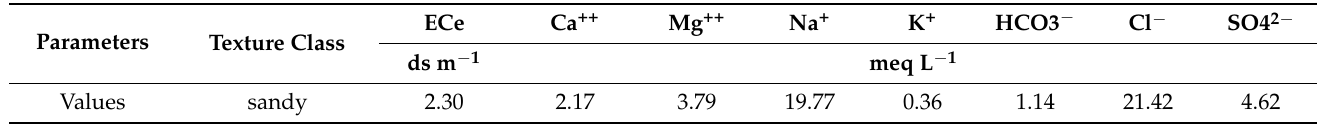
Table 9. The orchard soil physical and chemical